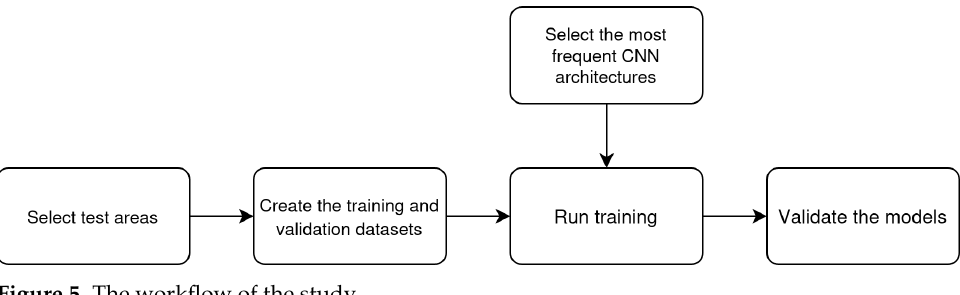
Figure 5. The workflow of the study.